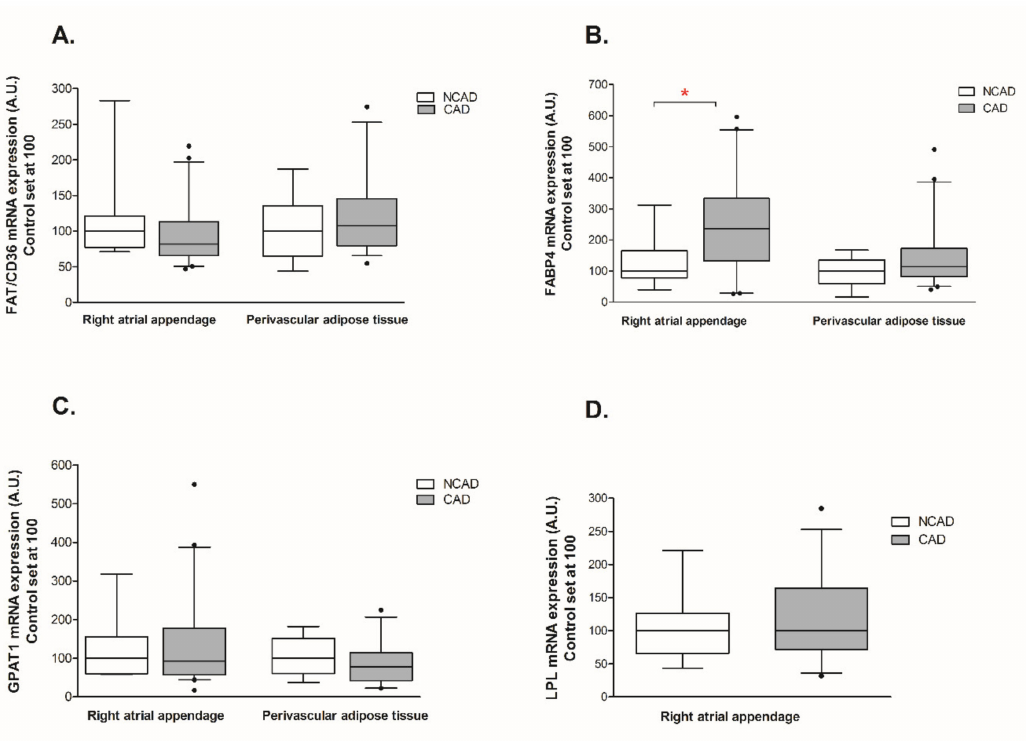
Figure 5. Myocardial and perivascular adipose tissue genes expression of ( A ) fatty acid translocase (FAT / CD36), ( B ) fatty acid-binding protein 4 (FABP-4), ( C ) glycerol-3-phosphate acyltransferase 1 (GPAT1), ( D ) lipoprotein lipase (LPL) in the coronary atherosclerosis (CAD, n = 42) and control (NCAD, n = 11) patients. The inner horizontal line of a box represents the median. Box boundaries: 25–75 percentile; whiskers 5–95 percentile. Data are expressed as median ± SEM. For the sake of clarity, the control group median was set at 100, and the CAD group was scaled with respect to NCAD.